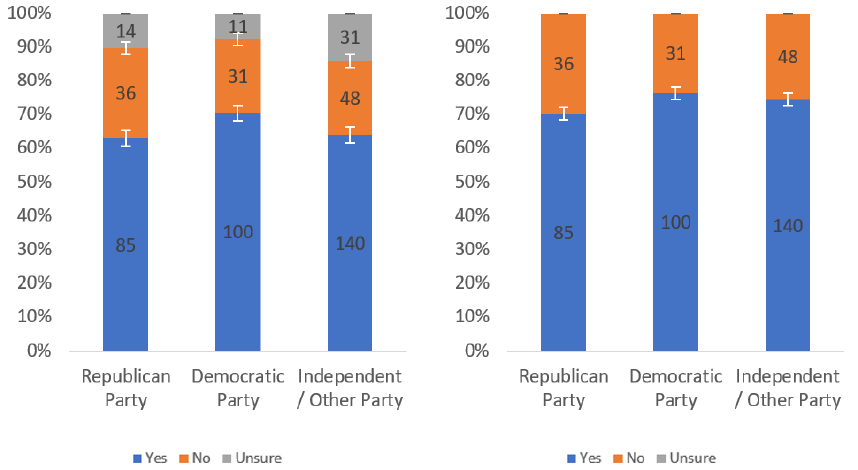
Figure 14. Responses regarding respondents’ willingness to review by party affiliation including ( left ) and excluding ( right ) unsure responses.